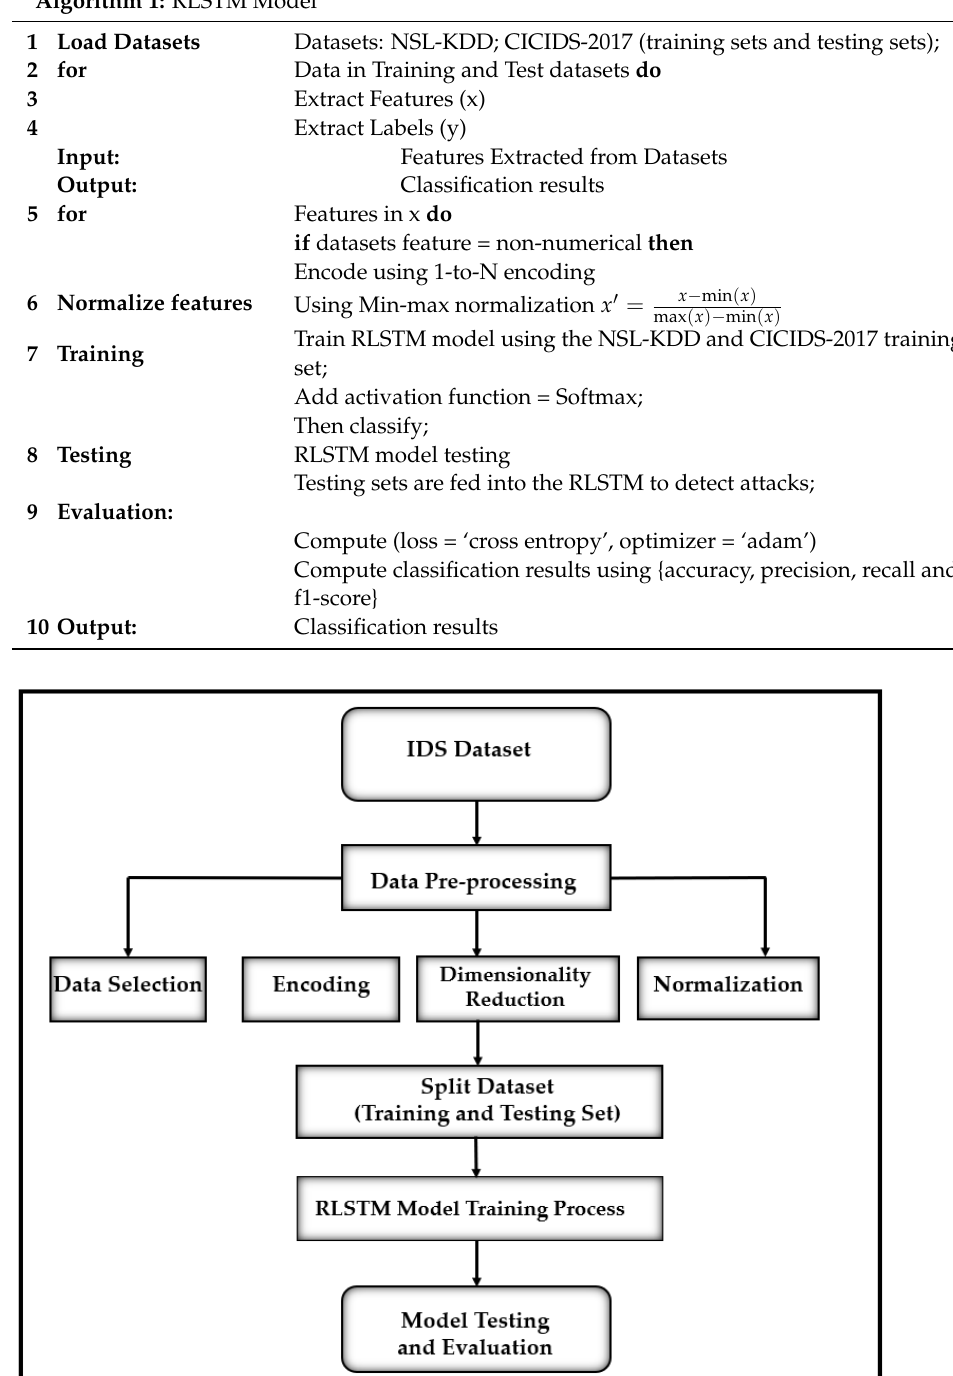
Algorithm 1: RLSTM Model